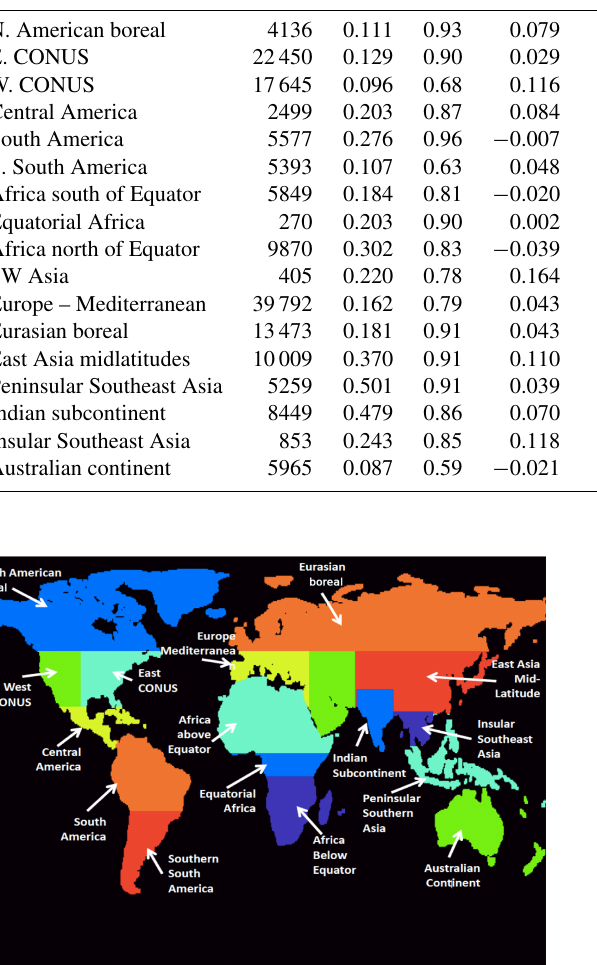
Figure 6. AOD differences between the MODIS 3km product and tion of AERONET AOD (a, b) MODIS AOD (c, d) . The left column shows Terra values and the right column shows Aqua. The global data set was sorted according to AOD, binned into bins with equal number of collocations, and then mean, median, and standard devia- tion of each bin were calculated. Red dots and lines show the mean. Black dots and lines show the median. The blue cloud indicates 1 standard deviation of each bin. The horizontal black line denotes zero difference, and the dashed lines indicate EE envelopes. Posi- tive values indicate that MODIS AOD is higher than